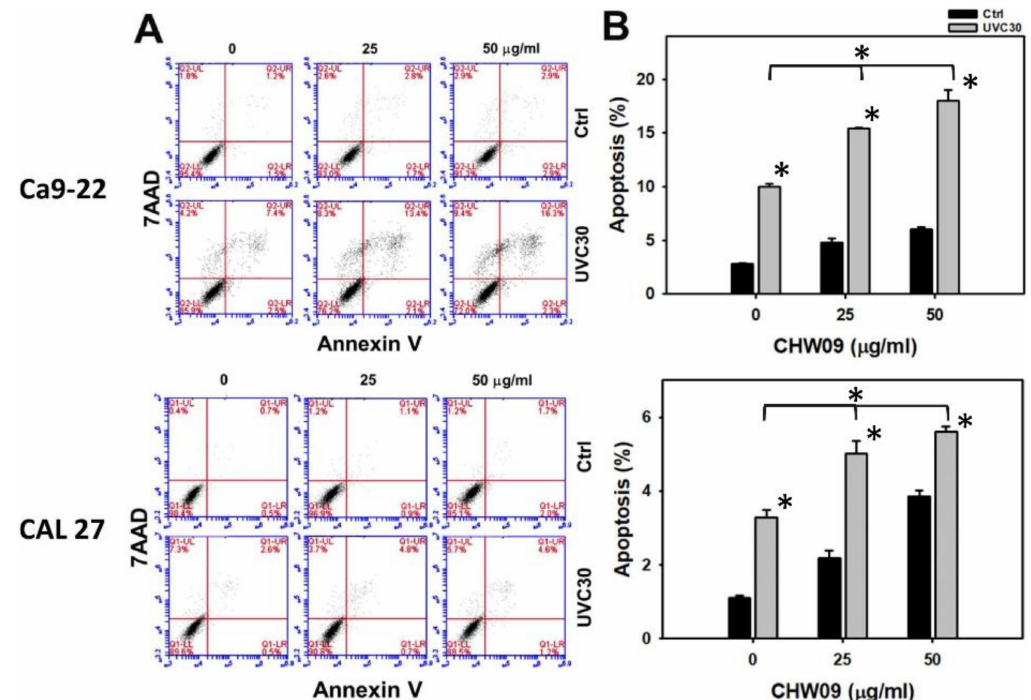
Figure 3. Changes of annexin V / 7AAD status of UVC and / or CHW09 treatments in oral cancer cells. Cells (Ca9-22 and CAL 27) were pretreated with UVC irradiation (0 and 30 J / m 2 ) and / or post-treated with CHW09 (control, 25, and 50 µ g / mL) for 24 h. ( A ) Representative pattern of annexin V / 7AAD analysis for UVC and / or CHW09 treatment. Annexin V ( + ) / 7AAD ( + or − ) is counted as apoptosis ( + ) (%) [10]. ( B ) Statistics in Figure 3A. Data, mean ± SD ( n = 3 independent experiments). For multiple comparison, significance of the di ff erence was examined by one-way ANOVA and the Tukey HSD Post Hoc Test. *, p < 0.0001. * without line indicates the significance between control and UVC30. * with line indicates the significance between UVC30 / CHW09 and